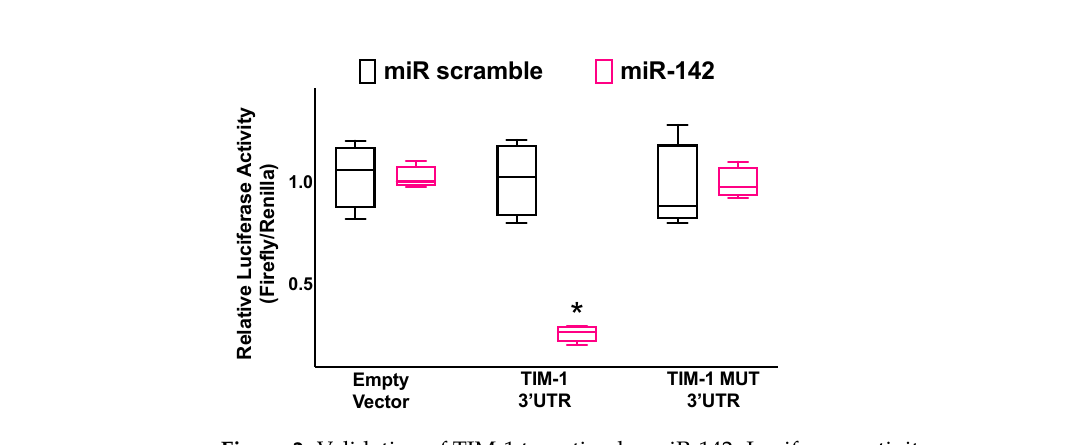
Figure 2. Validation of TIM ‐ 1 targeting by miR ‐ 142. Luciferase activity was measured in hBMECs 48 h after transfection, using the vector without TIM ‐ 1 3 ′‐ UTR (empty vector), the vector containing the wild ‐ type TIM ‐ 1 3 ′‐ UTR, and the vector containing a mutated TIM ‐ 1 3 ′‐ UTR (TIM ‐ 1 MUT); a non ‐ targeting miRNA (miR scramble) was employed as a further control. All experiments were performed at least in triplicate; the box ‐ and ‐ whiskers graph indicates the medians and the 5th–95th percentiles; * p < 0.01 vs. miR scramble.